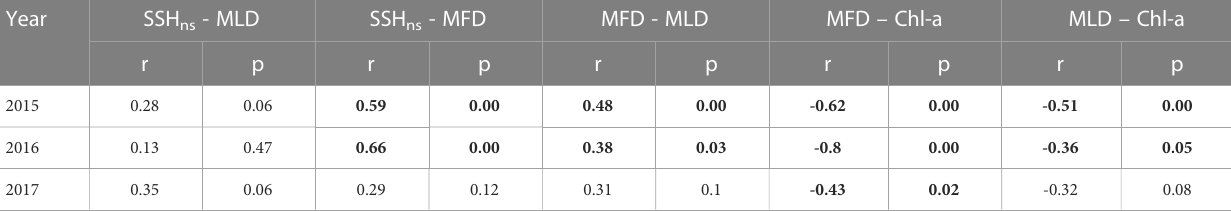
TABLE 5 Correlations between non-steric sea surface heights, maximum fl uorescence depth, mixed layer depth and surface Chl-a concentrations.